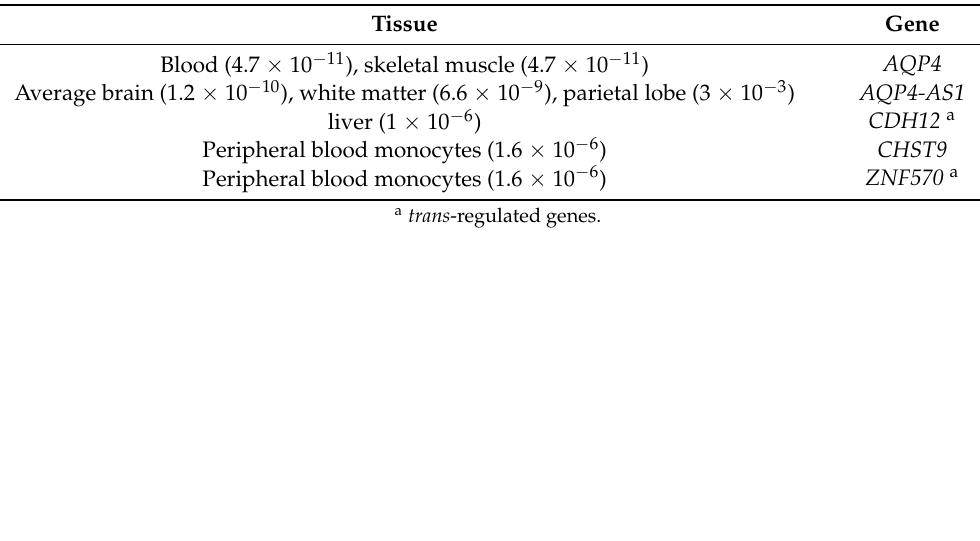
Table 2. Variant rs528732638 and its high LD variants showed expression quantitative trait loci (eQTL) effects on multiple